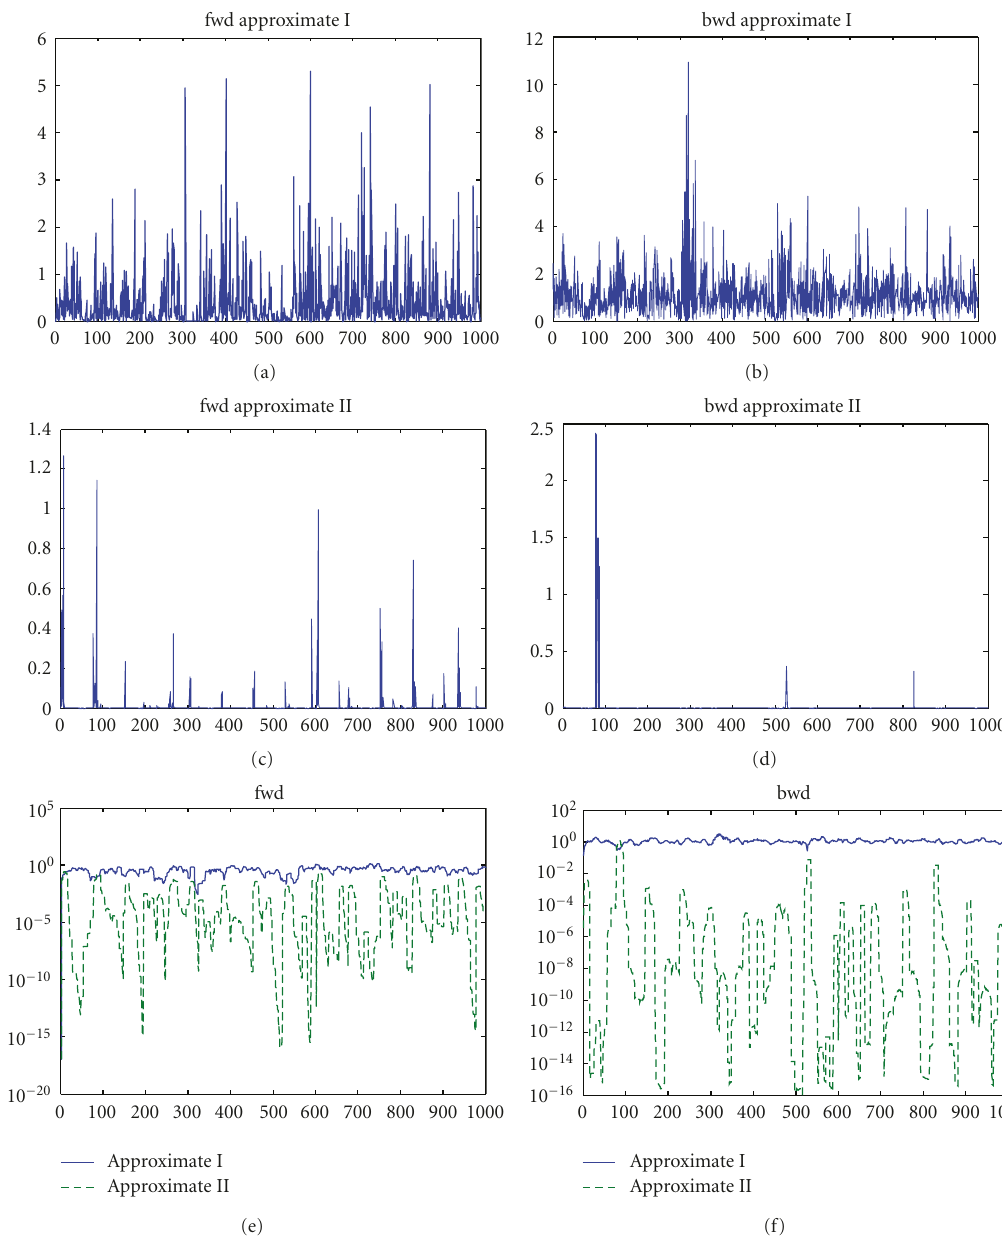
Figure 8: KL divergence caused by approximate inference. (a) Forward approximate I. (b) Backward approximate I. (c) Forward approximate II. (d) Backward approximate II. (e) Comparison between smoothed KL divergence of forward approximates I and II in log domain. (f) Comparison between smoothed KL divergence of backward approximates I and II in log